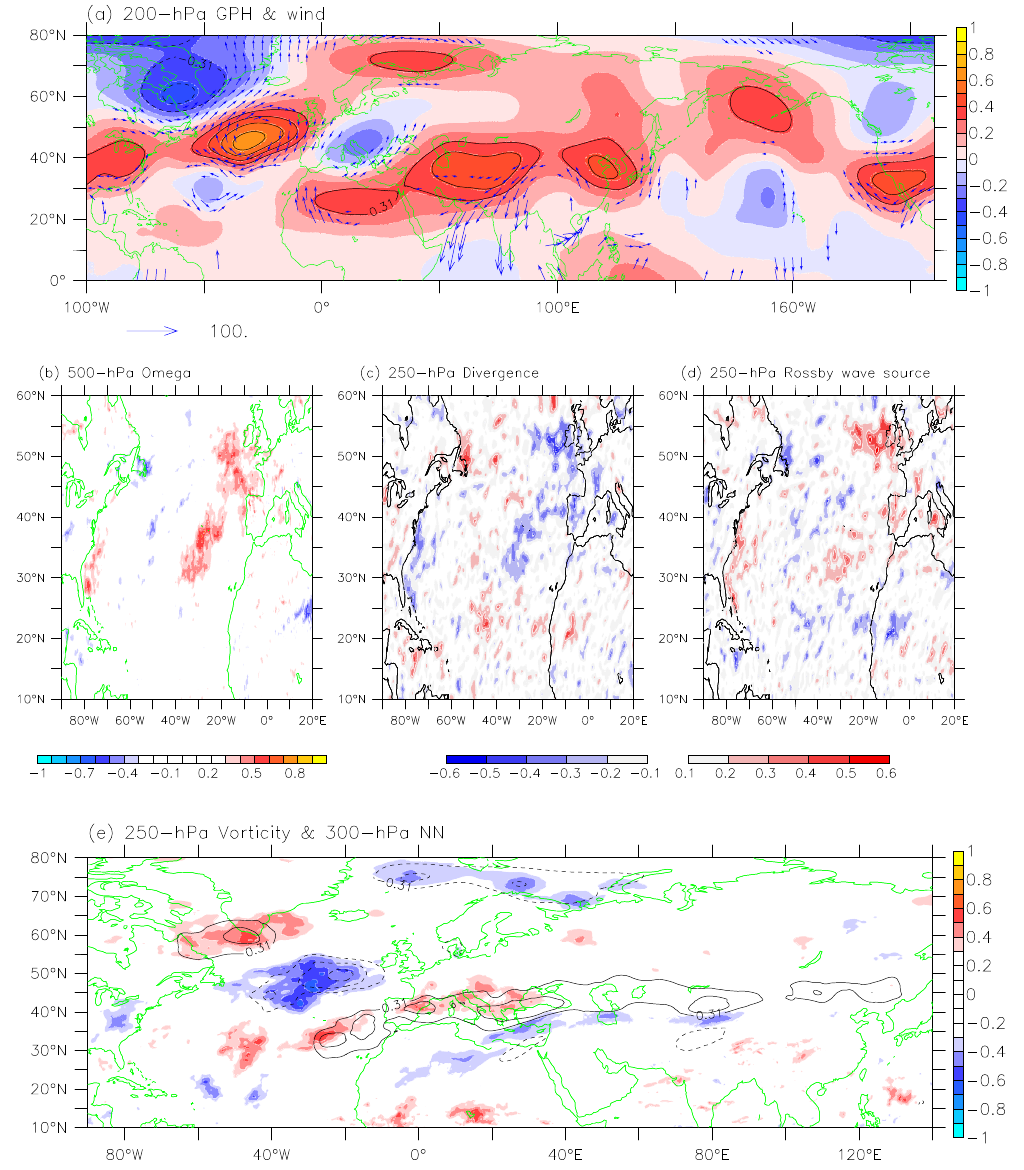
Fig. 3 Azores High correlation. Correlation of AH with a 200-hPa GPH (shaded) and regression of 200-hPa winds onto AH (blue vectors), black contours show the GPH signi fi cance at 95% con fi dence level. Correlation of AH with b 500-hPa vertical velocity (shaded), c 250-hPa Divergence, d 250-hPa Rossby wave source, e 250-hPa Vorticity (shaded) and 300-hPa Brunt – Väisälä frequency (NN, black contours). White contours in ( c ) and ( d ) shows the signi fi cance at 95% con fi dence